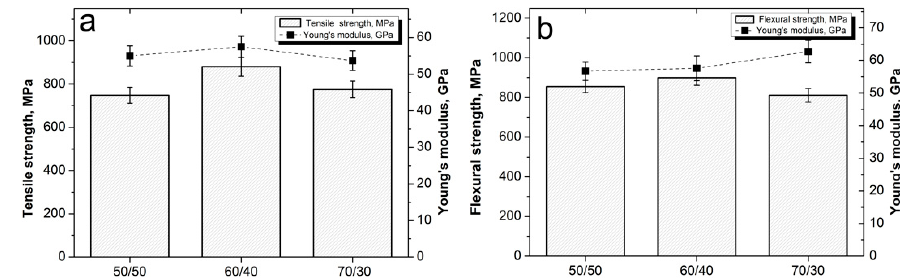
Figure 10. ( a ) Tensile and ( b ) flexural properties of the CF/PSU composites with various fiber to polymer ratios.